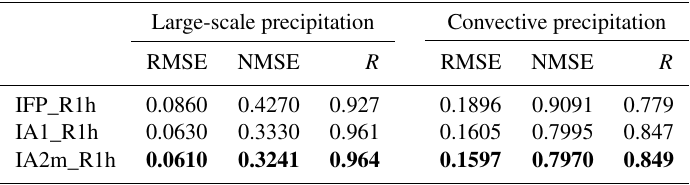
Table 4. Root-mean-square error (RMSE, mmh − 1 ), normalised root-mean-square error (NMSE), and correlation coefficient ( R ) between the interpolated data sets IFP, IA1, and IA2m and the true ECMWF data R1h, based on the global data set for the year 2014 and large-scale and convective precipitation. Note that NMSE is calculated only for data pairs clearly different from zero as described in the